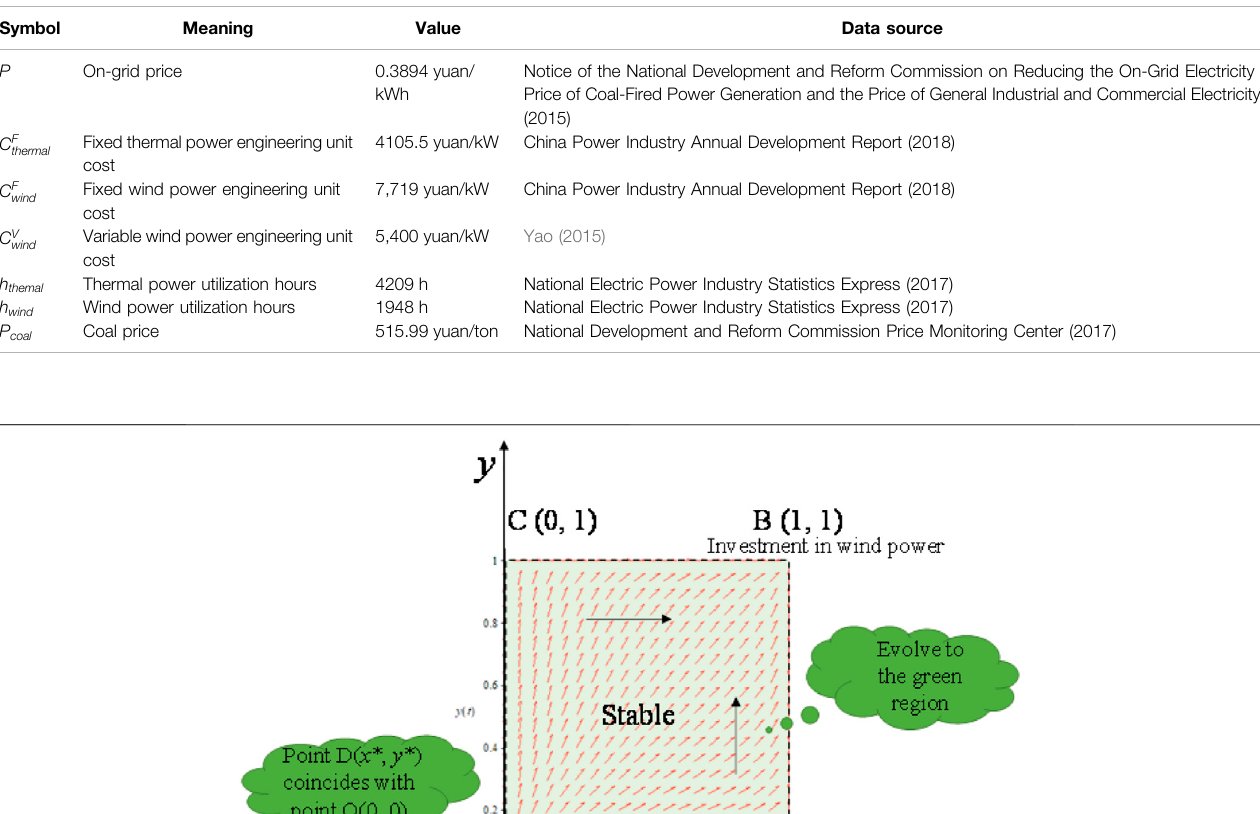
TABLE 2 | Parameter and the value in our model.